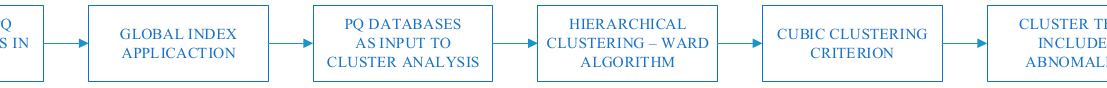
Figure 1. Simplified methodology scheme.